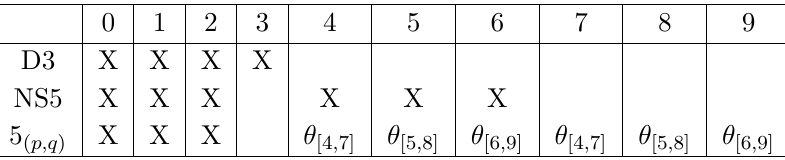
Table 1 . Brane array realizing 3d N = 3 theories.